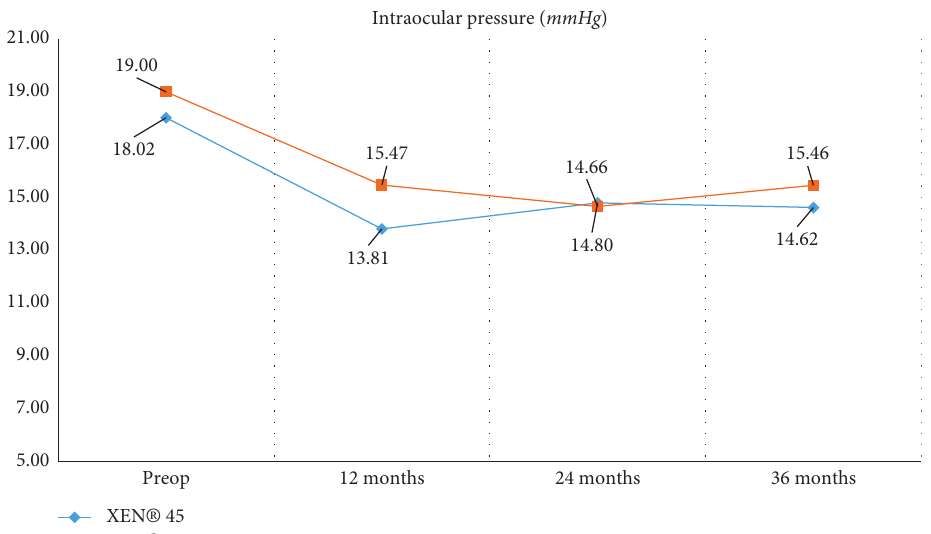
Figure 1: Change in mean IOPs over 12, 24, and 36 months follow-up visits for XEN ® 45 and XEN ® 63.